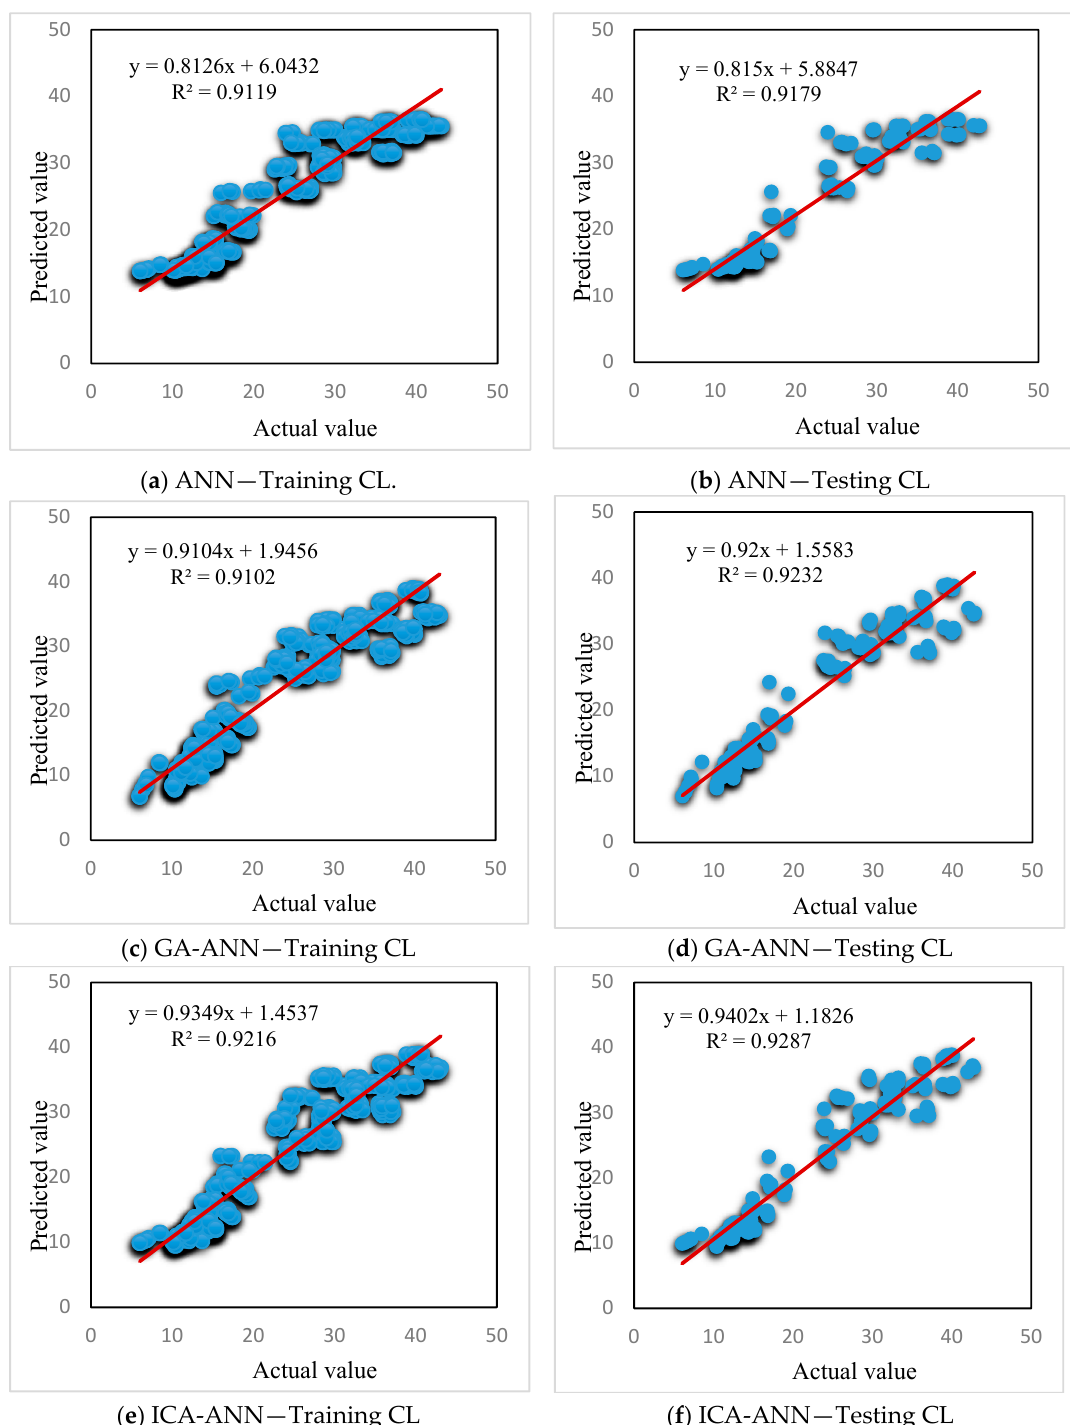
Figure 14. The regression between the actual and predicted CL.